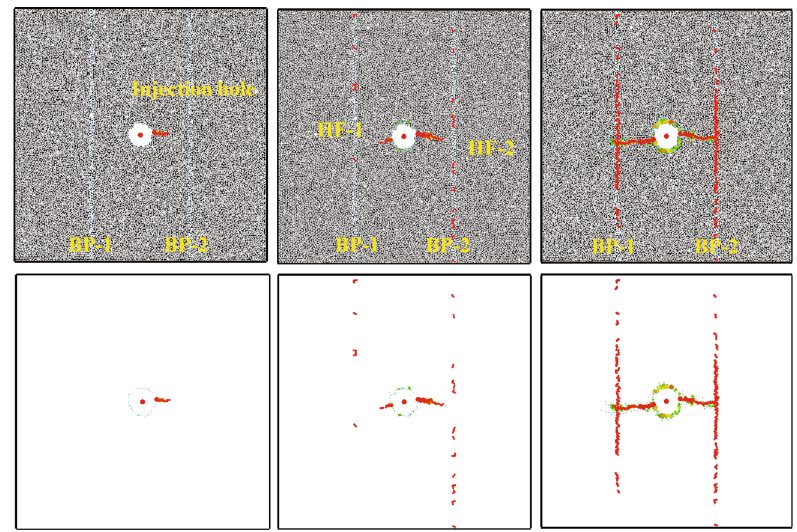
Figure 11: Group 1-3 hydraulic fracture morphology and interactive penetration mode.